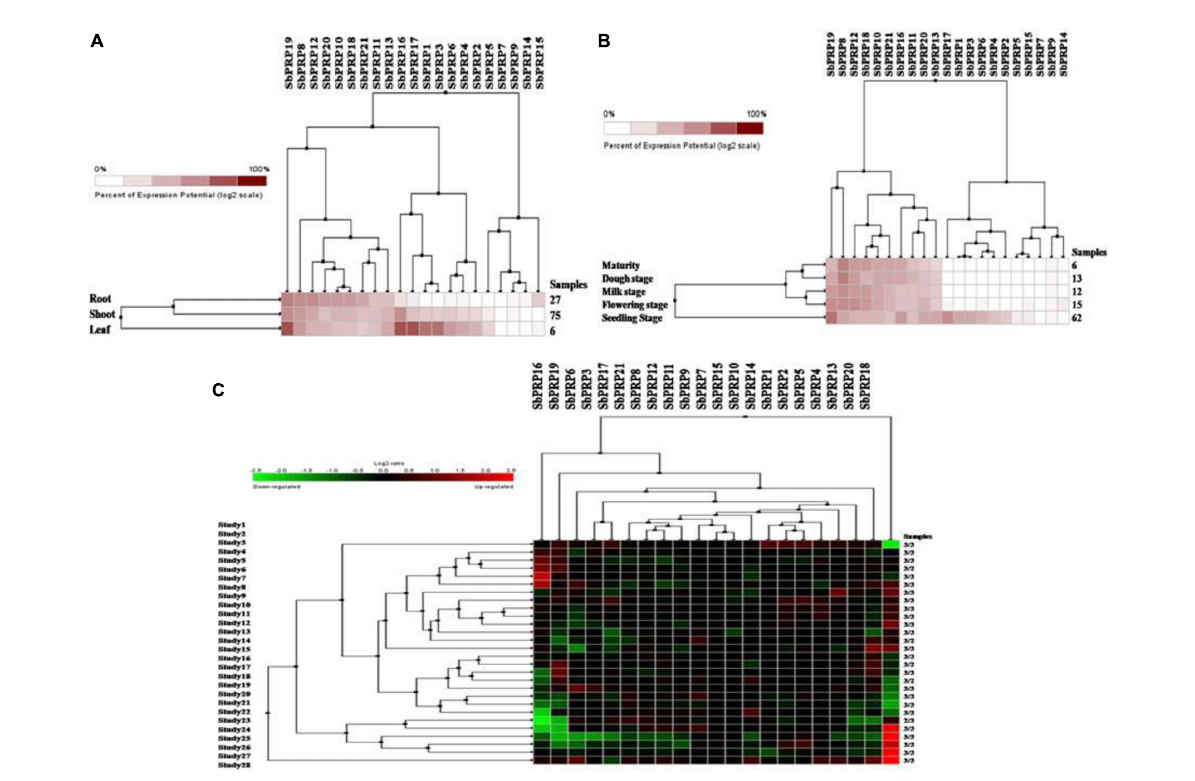
FIGURE6 Digital expression profile of SbPRP genes in different organs, developmental stages under cold and drought stresses. (A) SbPRP in anatomical tissues, (B) SbPRP genes in developmental stages, (C) SbPRP gene expressions under cold and drought stress